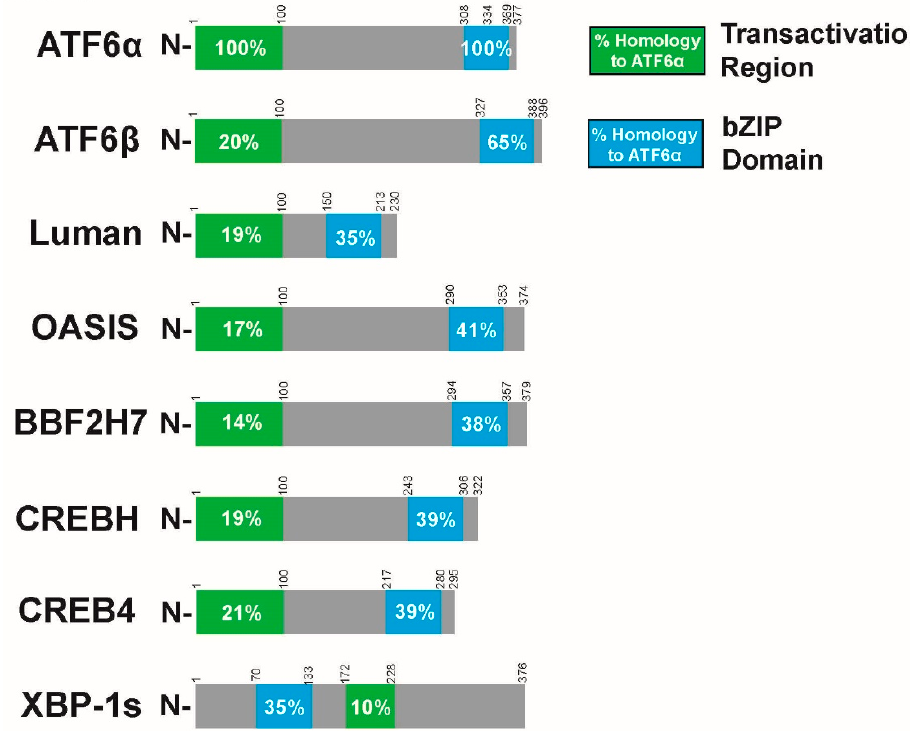
Figure 5. Sequence homologies to soluble N-terminal ATF6 α amongst OASIS family members. While all OASIS members have similar structure in their N-terminal fragments, they have low sequence homology to ATF6 α in their TADs. There is greater homology, however, in their bZIP domains, especially for the member most closely related to ATF6 α , ATF6 β . Fellow ER stress effector XBP-1s, which is a bZIP transcription factor but is not in the OASIS subfamily, is included here for comparison.